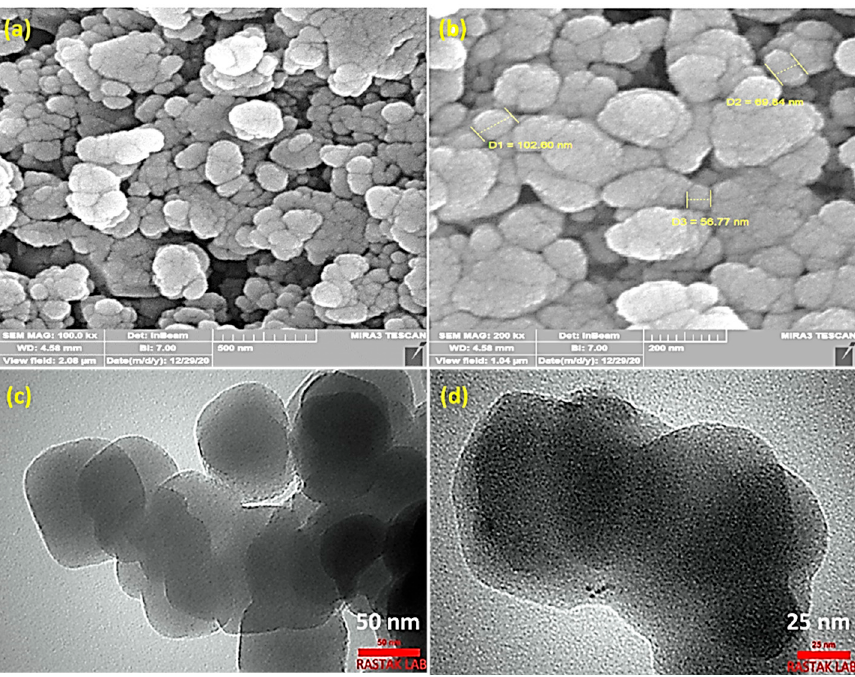
Figure 4. ( a ) The SEM, ( c ) TEM of ZIF-67, ( b ) The SEM, and ( d ) TEM of Pt@ZIF-67.